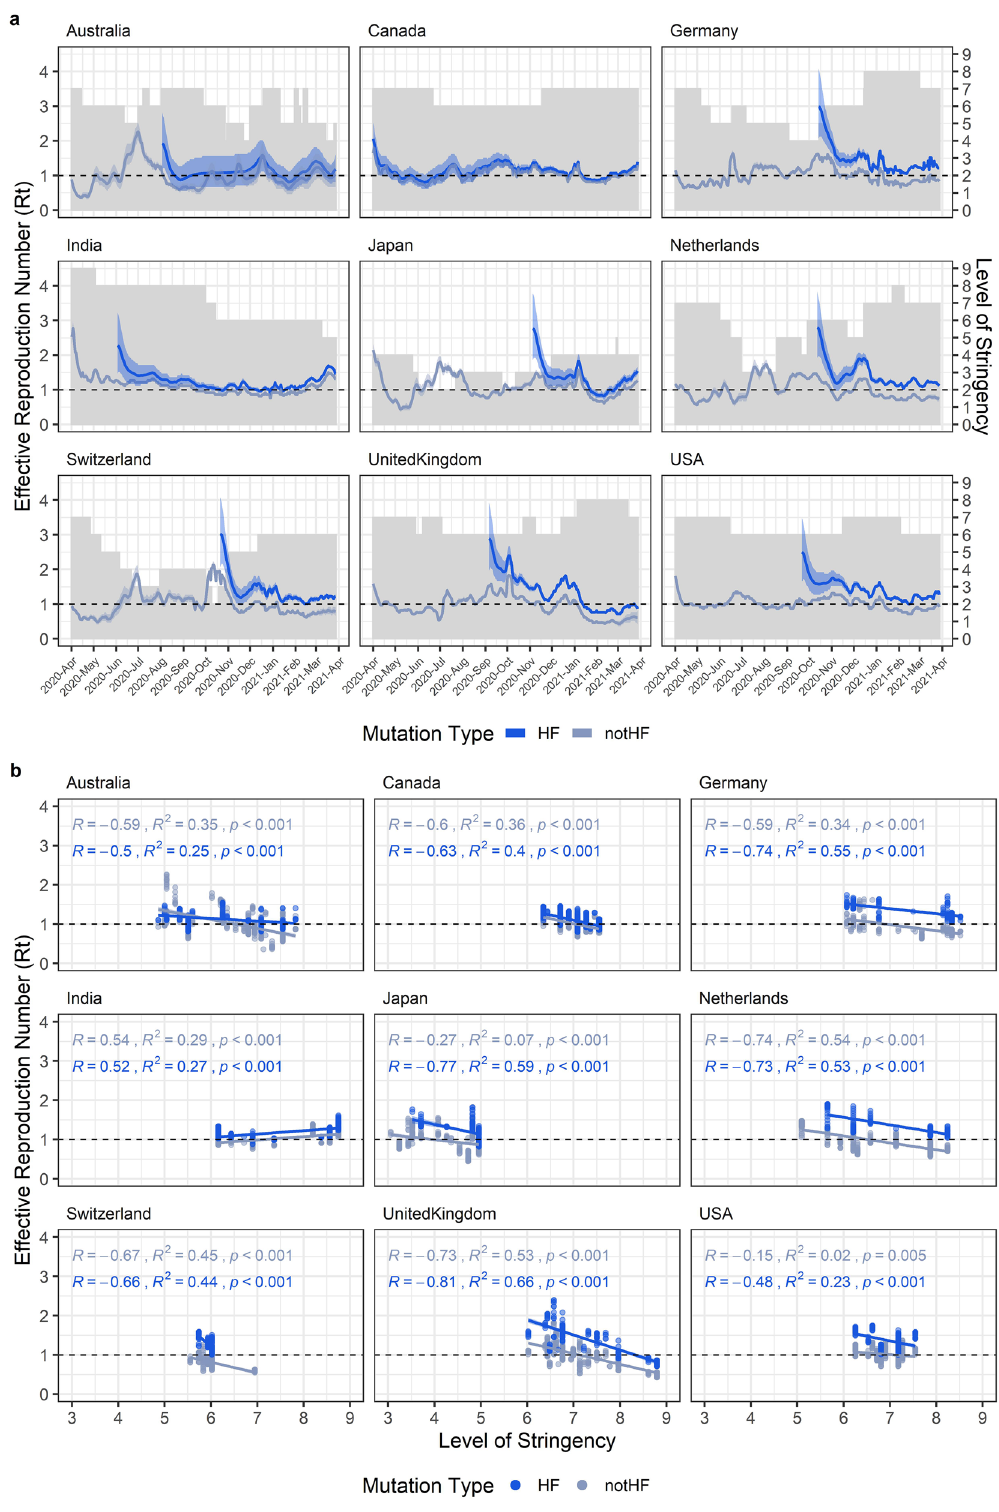
Figure 3. Effective reproduction number (Rt) of HF N501Y and not-HFN 501Y are correlated with level of stringency. (a) Each panel shows the estimated effective reproduction number of SARS-CoV-2 bearing (blue) or not (grey) the HF mutation N501Y (HF or notHF, respectively) in different countries. Grey bars are showing the level of stringency. Shades show a 97.5% confidence interval in the estimation of Rt. (b) Correlation of Rt after 14 days of the implementation of the level of stringency with the level of stringency. Each panel shows the independent analysis of different countries. Spearman correlation values (R), R-square of the linear regression model (R 2 ), and p-value of the correlation is showed in the left-up of each panel in this order. Colors represent the same as in (a)